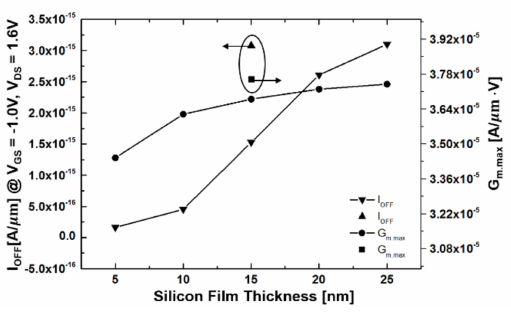
Figure 13. I OFF and G m.max dependence of silicon film thickness on the PiFET with slope